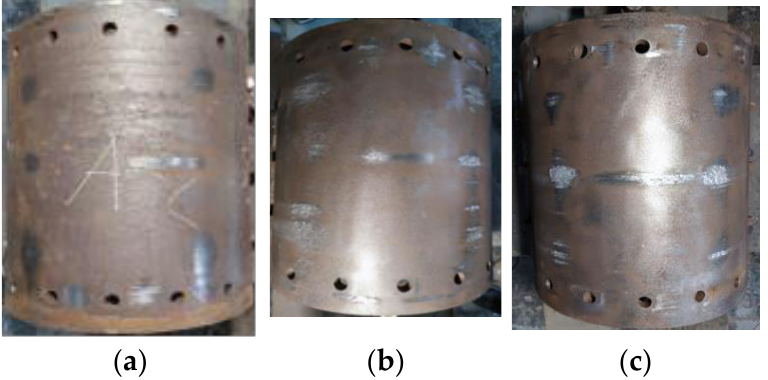
Figure 7. Influence of axial compression ratio on wear of lower arc end-plates: ( a ) H350 − 1 − 1; ( b ) H350 − 1 − 2; ( c ) H350 − 1 − 3.